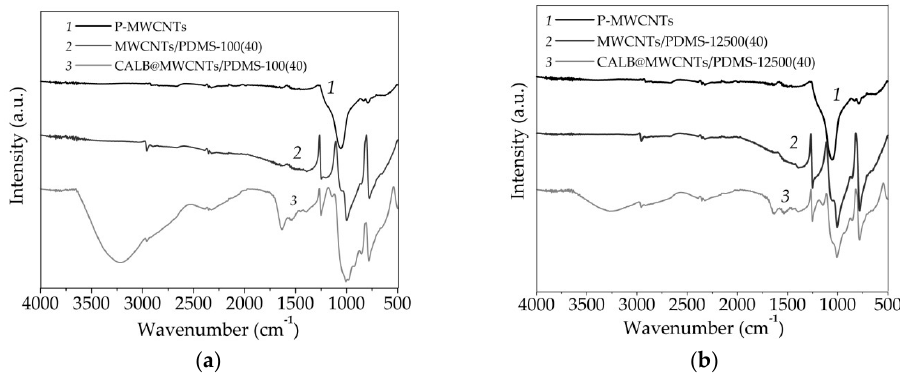
Figure 3. FTIR spectra of ( a ) P-MWCNTs, MWCNTs/PDMS-100, and ( b ) MWCNTs/PDMS-12500 nanocomposites, before and after lipase immobilization.